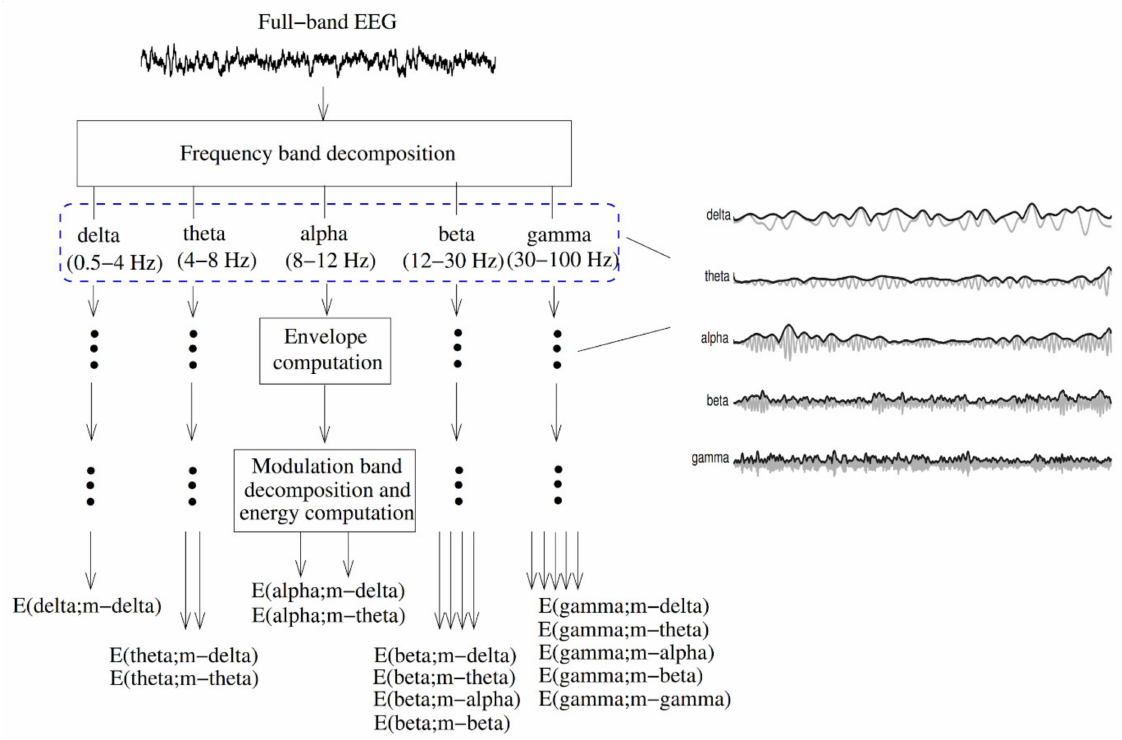
Figure 11. Signal processing steps used to compute resting EEG spectro-temporal modulation energy (reproduced with permission from